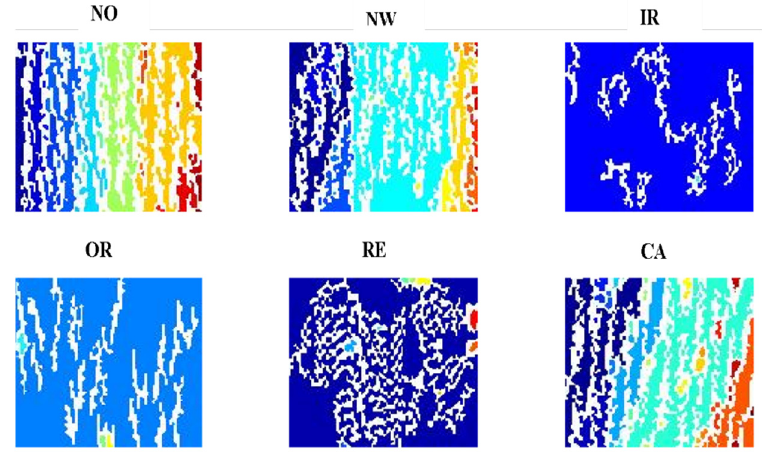
Figure 5. Examples of the generated vibration image using RGBVI technique for bearing vibration with six health conditions [36].